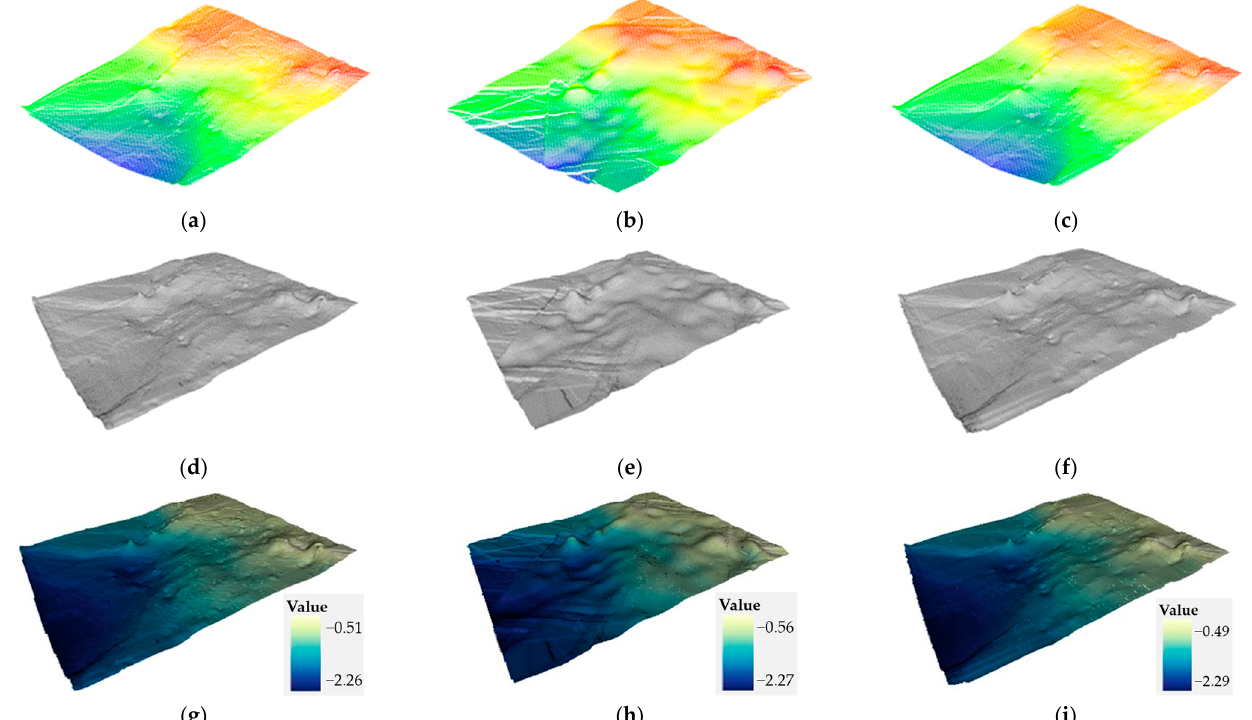
Figure 7. Modelling examples: ( a ) point cloud FCR; ( b ) point cloud OK; ( c ) point cloud IDW; ( d ) 3D model FCR; ( e ) 3D model OK; ( f ) 3D model IDW; ( g ) textured 3D model FCR; ( h ) textured 3D model OK; ( i ) textured 3D model IDW.